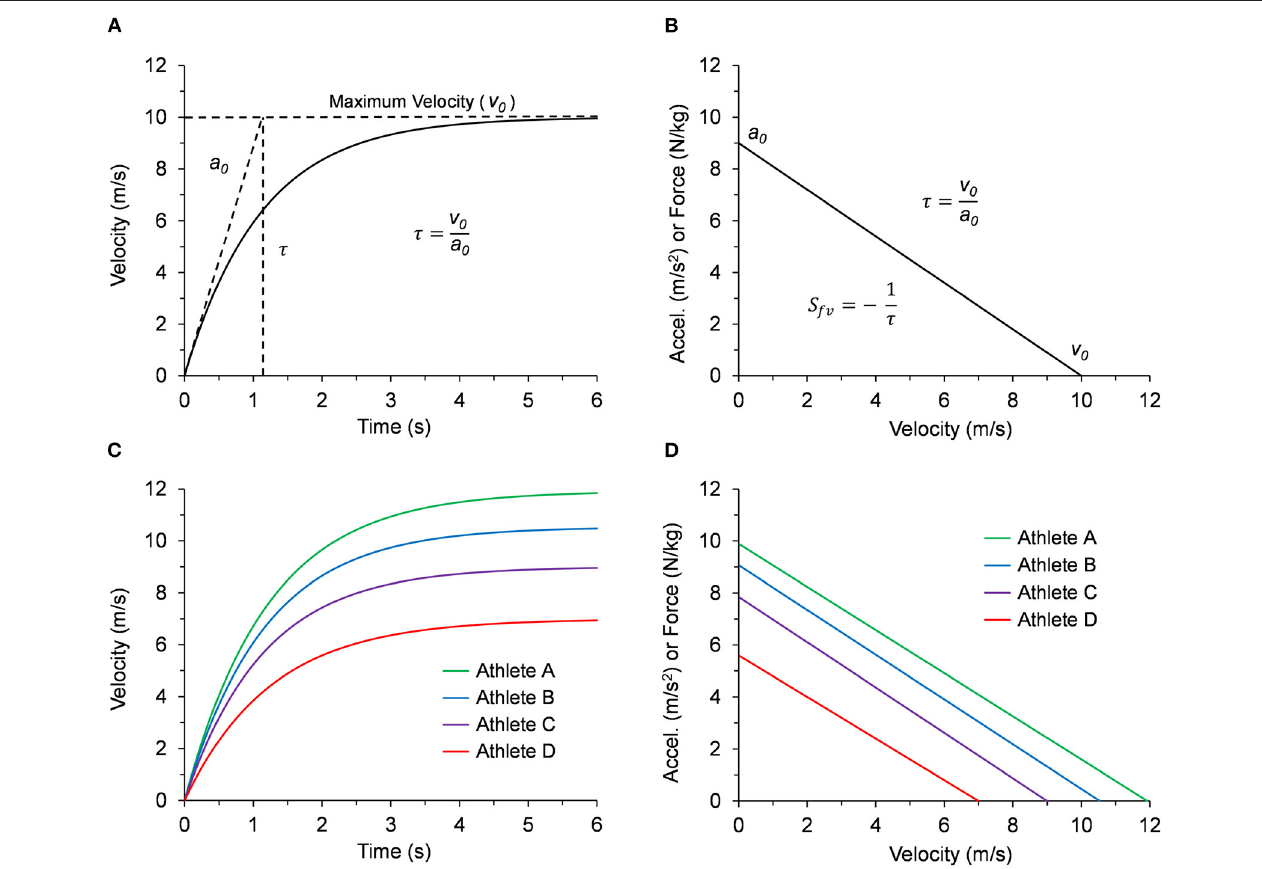
FIGURE 1 | (A) Example graph of the exponential velocity vs. time curve during a maximum effort sprint. The slope at t = 0 is defined by the limit a 0 and the velocity curve approaches the limit v 0 according to the time constant τ = v 0 / a 0 . (B) The corresponding linear curve for acceleration (m/s 2 ) vs. velocity, or equivalently, force relative to body mass (N/kg) vs. velocity. The negative slope of the linear acceleration vs. velocity curve S fv can be defined in terms of the time constant ( S fv = - a 0 / v 0 = − 1/ τ ). (C) Velocity vs. time curves for all four representative athletes listed in Table 1 . (D) Acceleration or force vs. velocity curves for all four representative athletes listed in Table 1